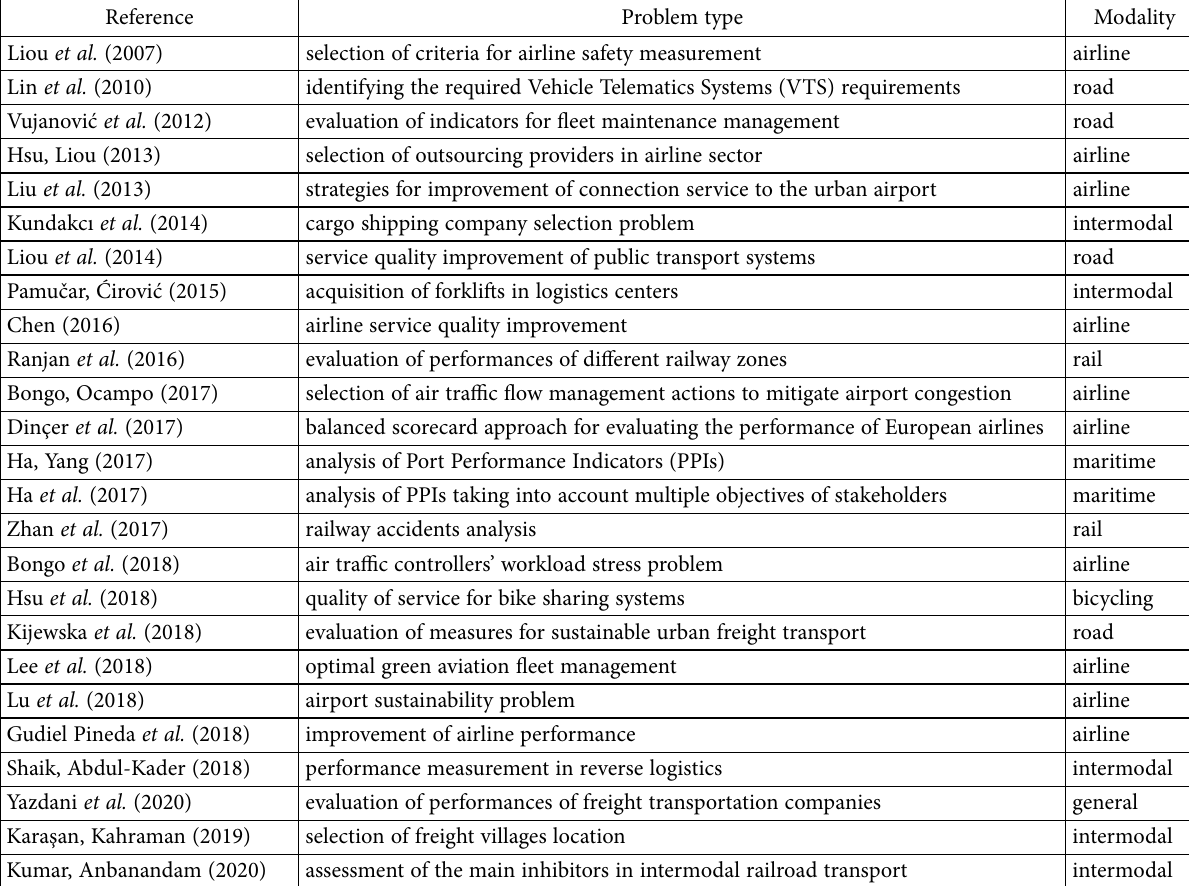
Table 2. Main characteristics of relevant DEMATEL and ANP applications in transportation / logistics domain